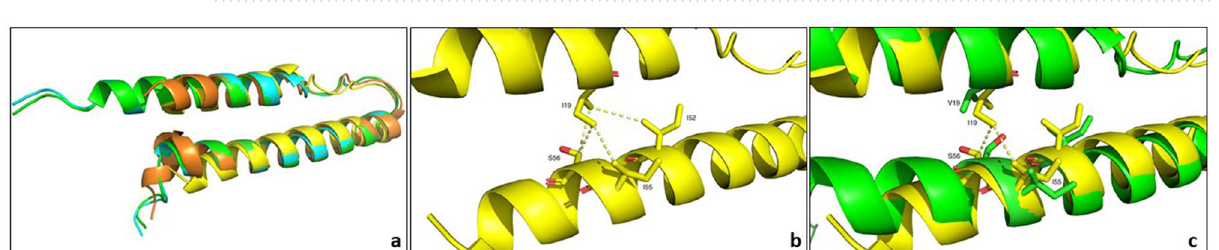
Figure 7. Rev structures. 8-G and 9-G Rev structures were predicted using AlphaFold Colab and compared to published crystal structures of NL4-3 Rev with (PDB: 4PMI) and without (PDB: 3LPH) RNA. The 8-G and 9-G proteins were truncated at residue 68, to correspond with the NL4-3 structures; the remainder of the protein chains were disordered in the predicted structures, with little to no secondary structure. ( a ) Overlay of the four structures. Unbound NL4-3 Rev is shown in orange, RNA-bound NL4-3 in yellow, 8-G in green, and 9-G in cyan. ( b ) The OD helices of RNA-bound NL4-3 Rev, showing the interaction of I19 with I52, I55 and S56. The highlighted residues are conserved in the 9-G sequence. c. The same protein region as in b, with the 8-G Rev overlaid in